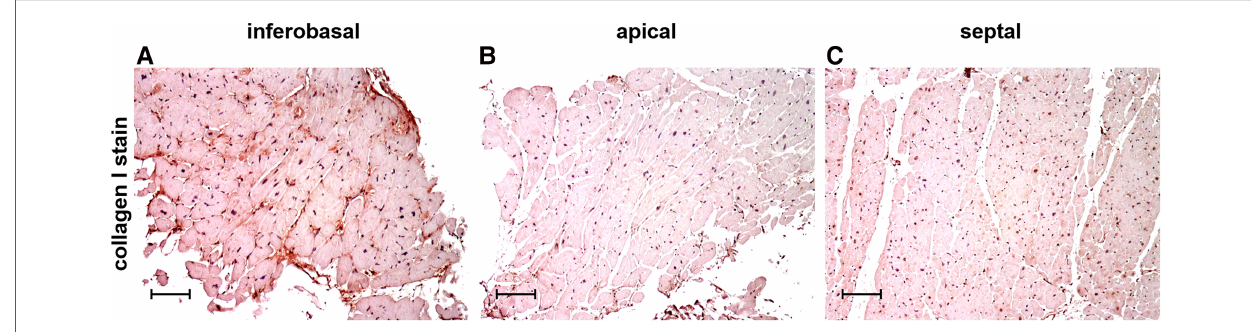
FIGURE 2 Immunohistochemical staining of collagen type I in cardiac biopsies obtained from the inferobasal ( A ), apical ( B ) and the septal regions ( C ) in MVP patients. Scalebars=100